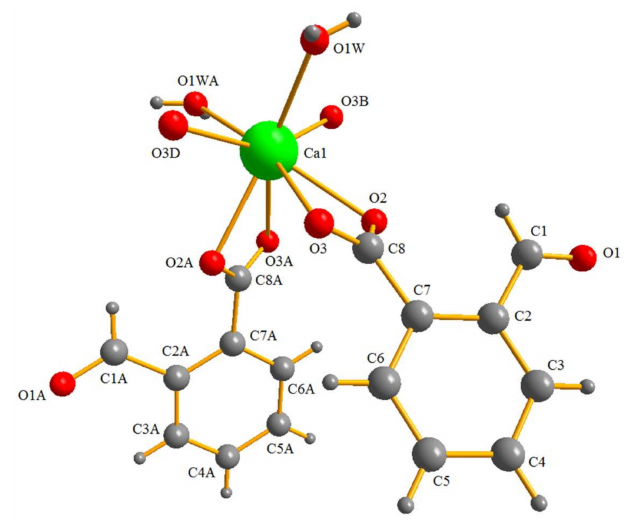
Figure 2. The coordination environment of Ca(II) ion in the Ca(II) coordination polymer. Symmetry